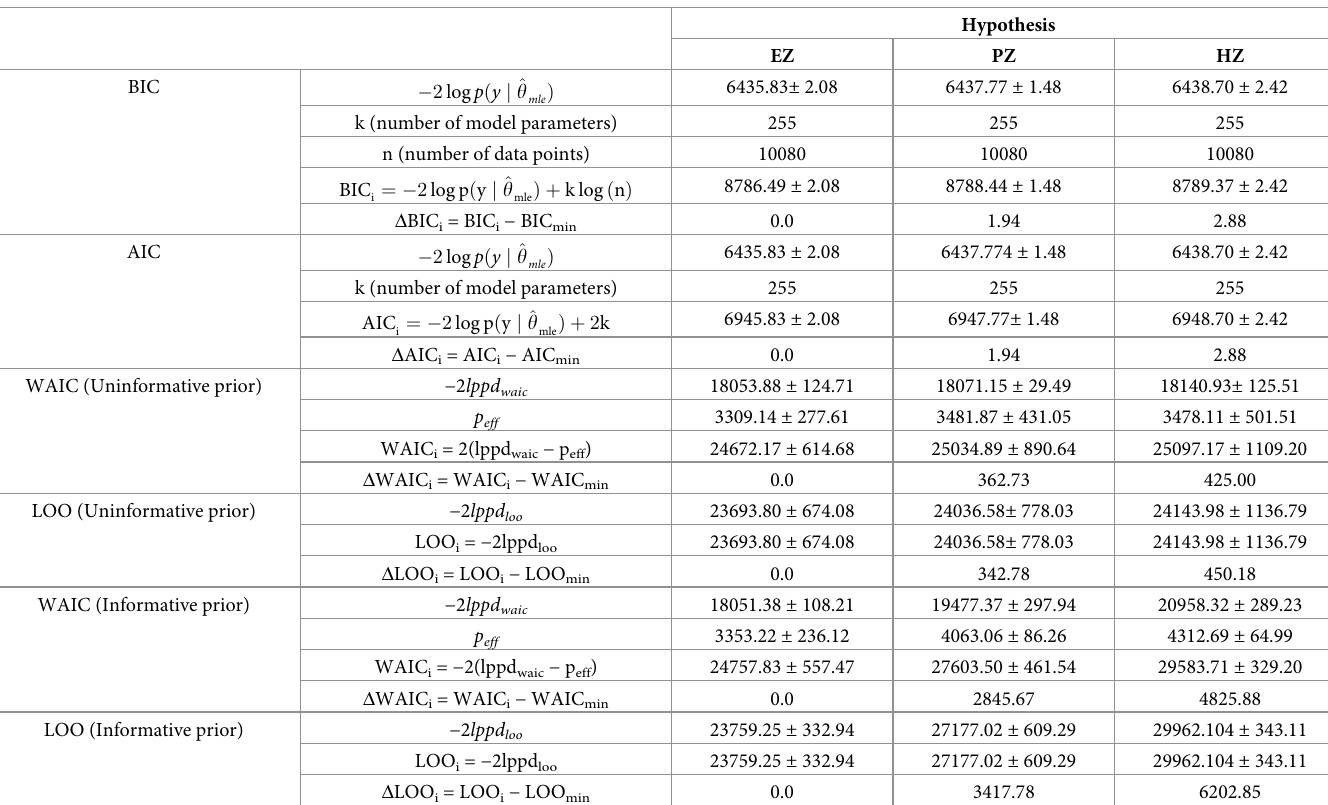
Table 1. Summary of epileptogenicity hypothesis testing using the classical and Bayesian information criteria (BIC/AIC/WAIC/LOO) in terms of deviance (-2 times log predictive density), penalty term, and Delta scores. Here, three hypotheses as EZ, PZ, and HZ are evaluated on the excitability parameter of a selected brain region, where the ground truth is EZ. The smaller deviance and penalty terms, the smaller the value of information criterion, the better the model’s predictive ability. The correct hypothesis has a Delta score of